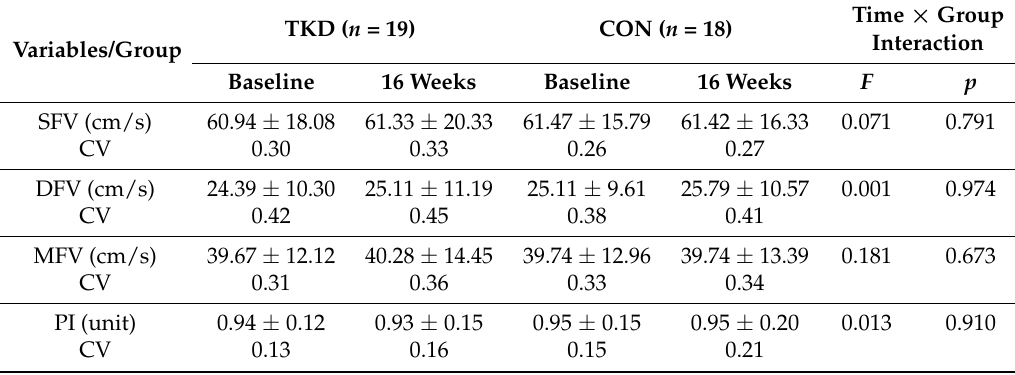
Table 5. Cerebral blood flow (CBF) velocities in the TKD and CON groups before and after the 16-week intervention.